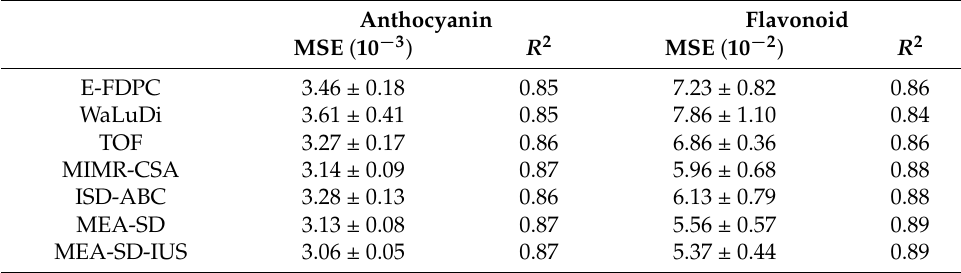
Figure 8. MSE curves of different methods on mulberry fruit dataset. ( a ) Anthocyanin contents. ( b ) Flavonoid contents. Table 10. Results of MSE and R 2 score for prediction of Anthocyanin and Flavonoid